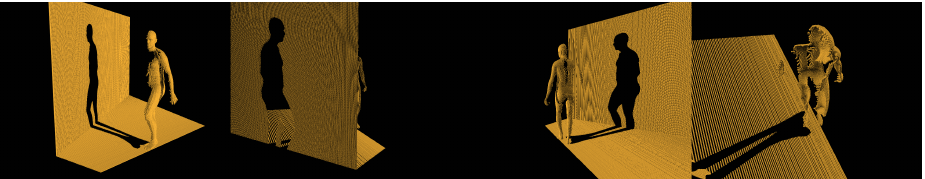
Figure 3. An example of neural network input that is created rendered depth frame converted to pointclouds with the help of camera intrinsic matrix K